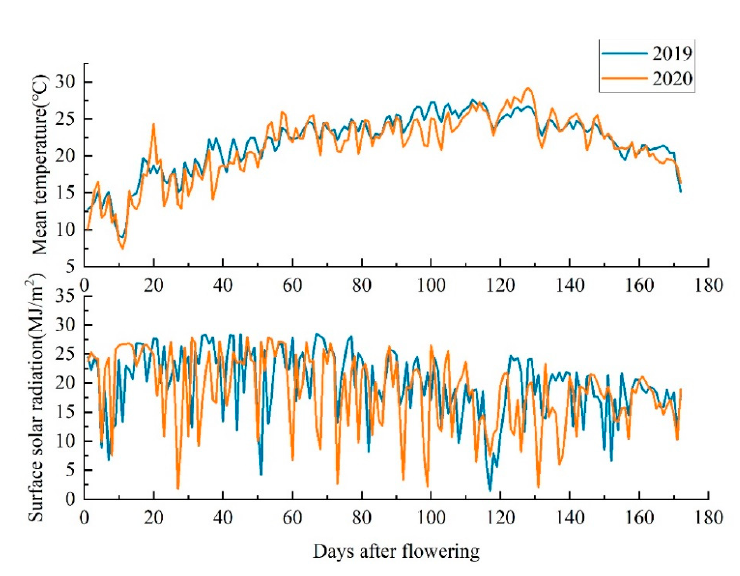
Figure 3. Daily mean temperature and surface solar